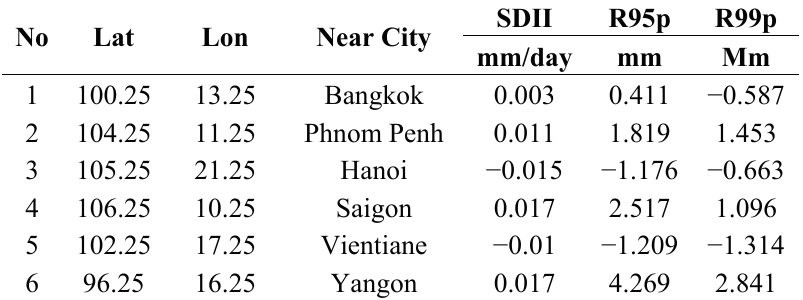
Table 6. The trends of intensity indices close to major cities in Indochina